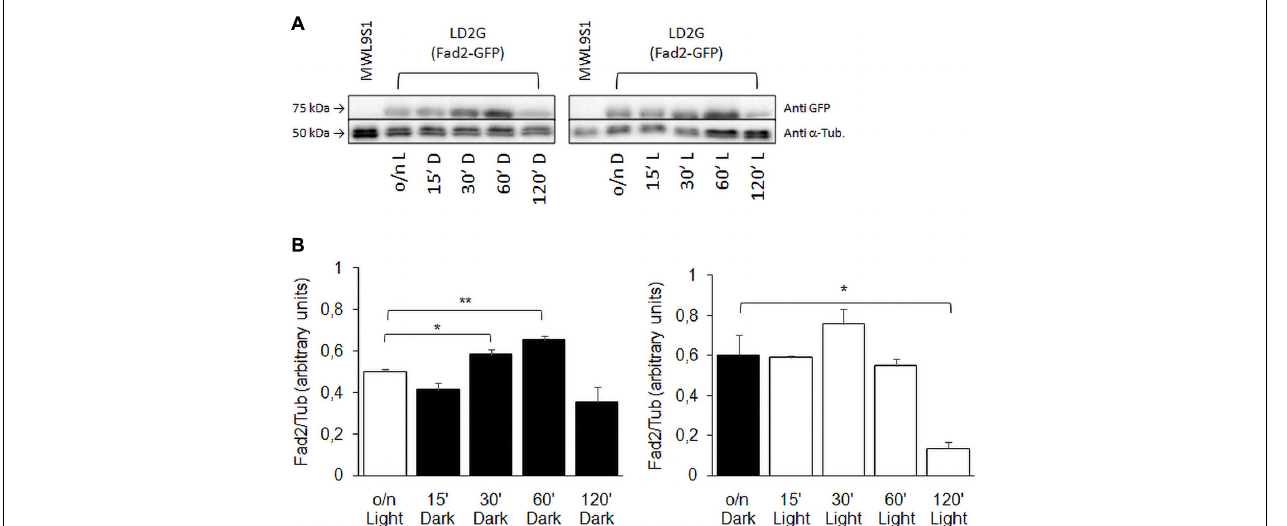
FIGURE 8 | Fad2 enzyme production in wild type strain with FAD2 fused to EGFP . (A) Shows Western blot against GFP-fused Fad2 protein, using strain LD2G (De Angelis et al., 2016). Cells were grown overnight in light or darkness and then shifted to darkness or light for 15, 30, 60, and 120 min. α -Tubulin detection was used as loading control. (B) Reports Fad2-GFP signal quantification with respect to α -Tubulin: values are averages of three independent determinations with SD. Significances: * p < 0.05; ** p < 0.01.